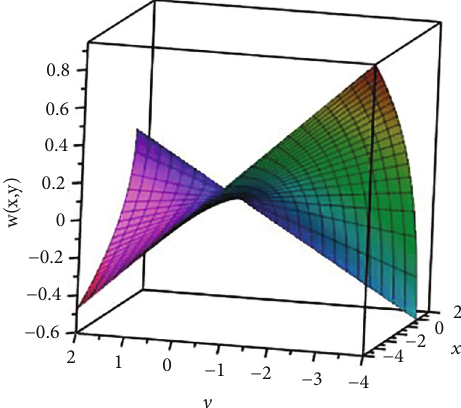
Figure 15: 3D complex plot of (60) for α = 1 and m 7 = 1